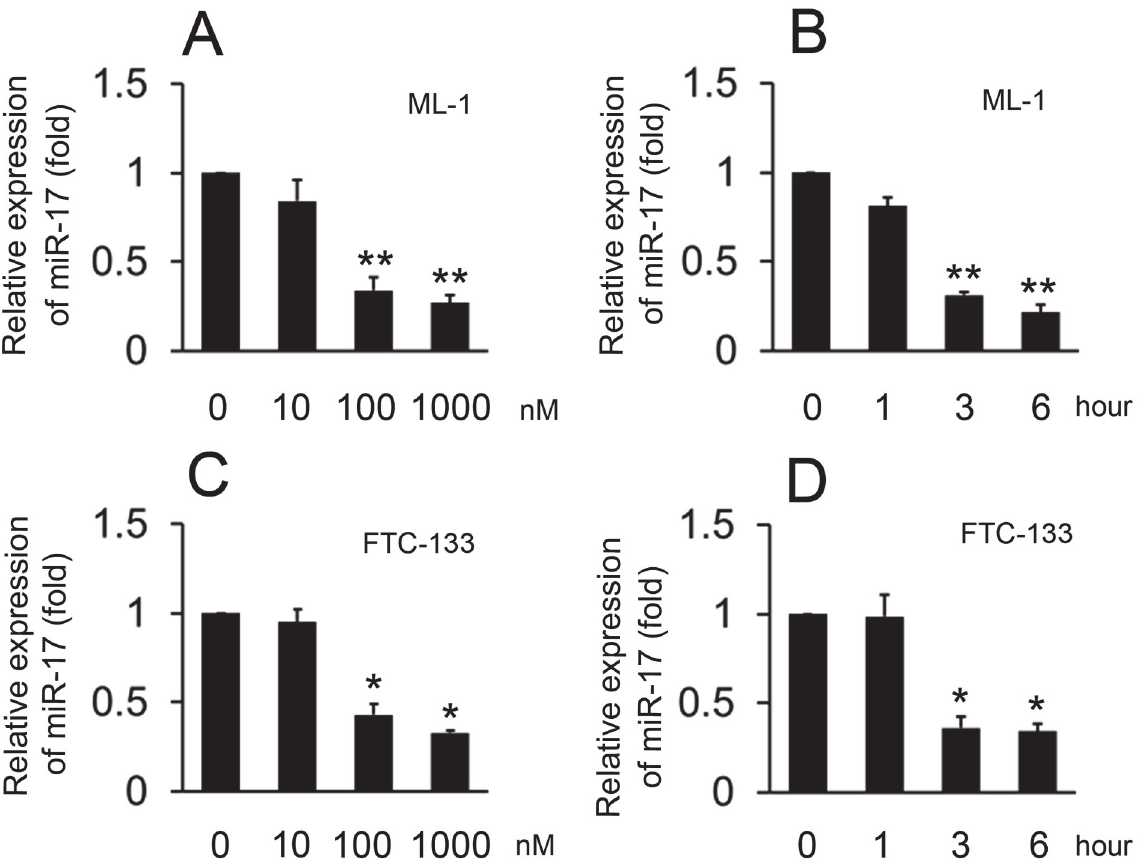
Fig 5. Effect of S1P on the expression of miR-17. Experiments were performed as described in Fig. 1, except miR-17 levels were quantified by real-time RT-PCR. The expression levels were normalized to U6 snRNA. Data represent means ± SD, n = 3 ( ** P < 0.01; * P <